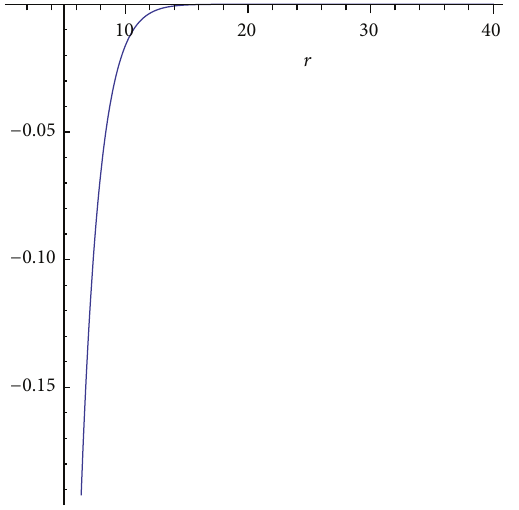
Figure 13: Solution of (48) as function of space (piezometric